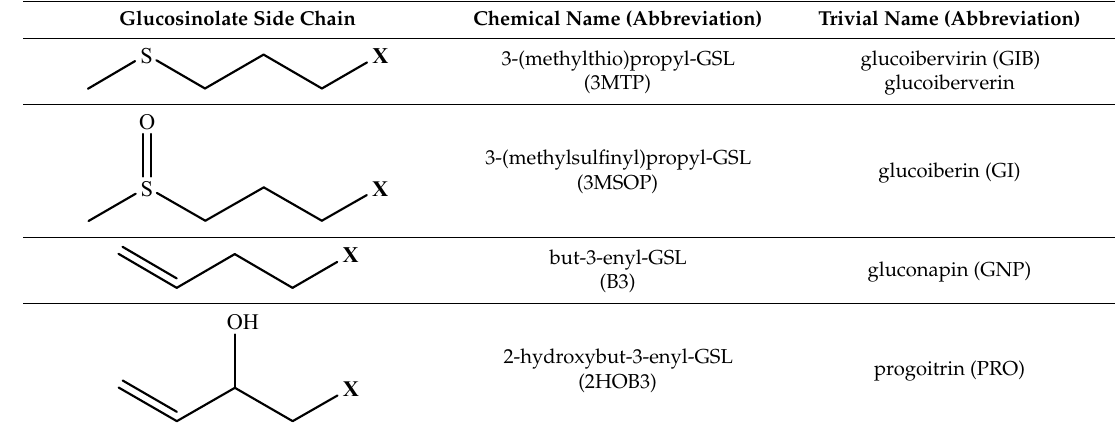
Table A1. Structures of the side chains for glucosinolates reported in Raphanus sativus tissues. The glucosinolate group in the glucosinolate is represented by “X”. Descriptive chemical names, their abbreviations, and commonly used trivial names, and their abbreviations, are included.